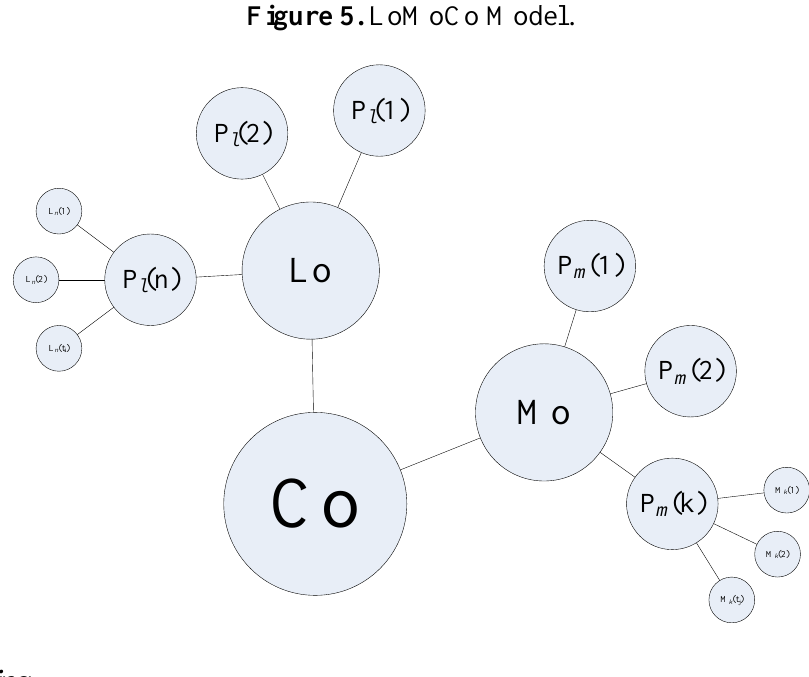
Figure 5. LoMoCo